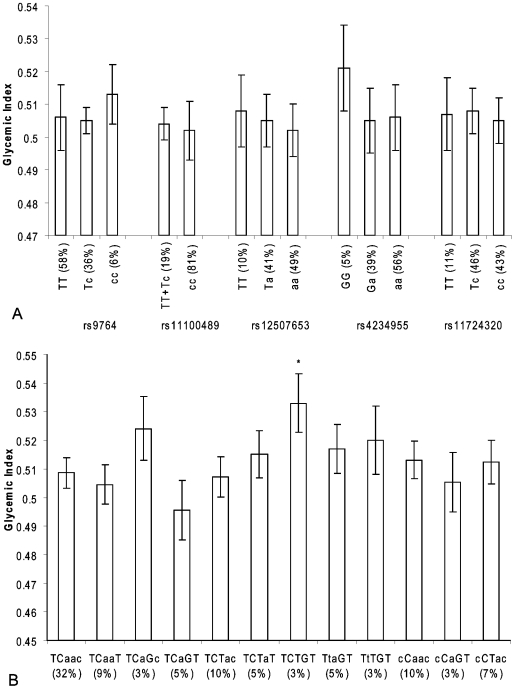

NPY1R/NPY5R variants and dietary glycemic index in the Hamlet population.Figure 5a shows the association of SNPs in the NPY1R/NPY5R region with dietary glycemic index. The ancestral alleles are indicated as capital letters. Figure 5b shows the association of NPY1R/NPY5R haplotypes with dietary glycemic index. The haploblocks consist of the SNPs rs9764, rs11100489, rs12507653, rs4234955 and rs11724320 and the ancestral alleles are indicated as capital letters. *p<0.05 (compared with linear regression model).